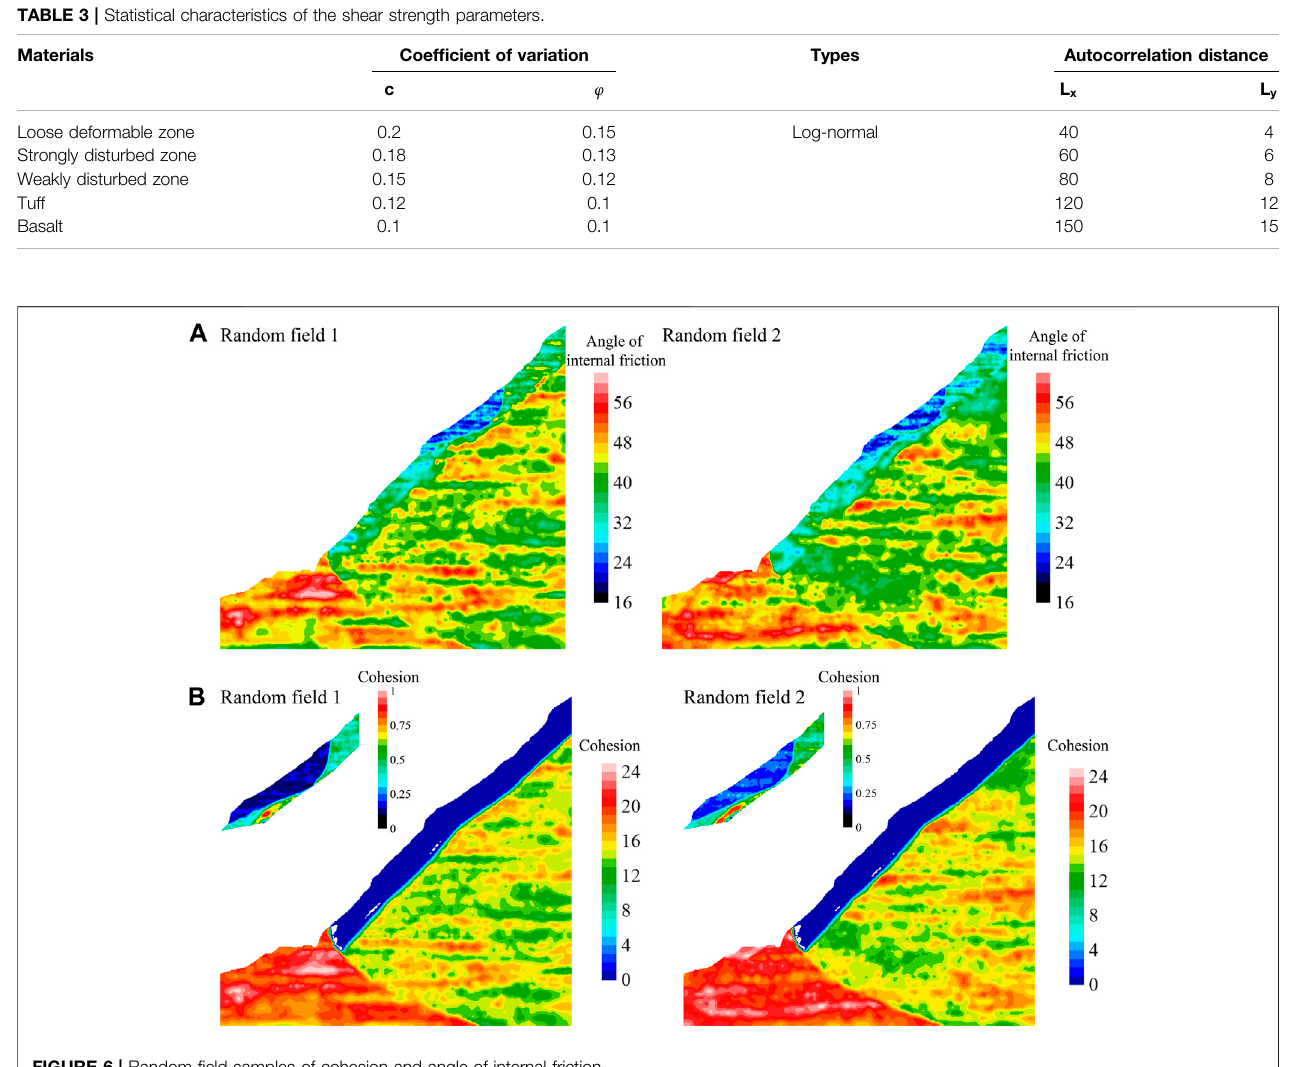
FIGURE 6 | Random fi eld samples of cohesion and angle of internal